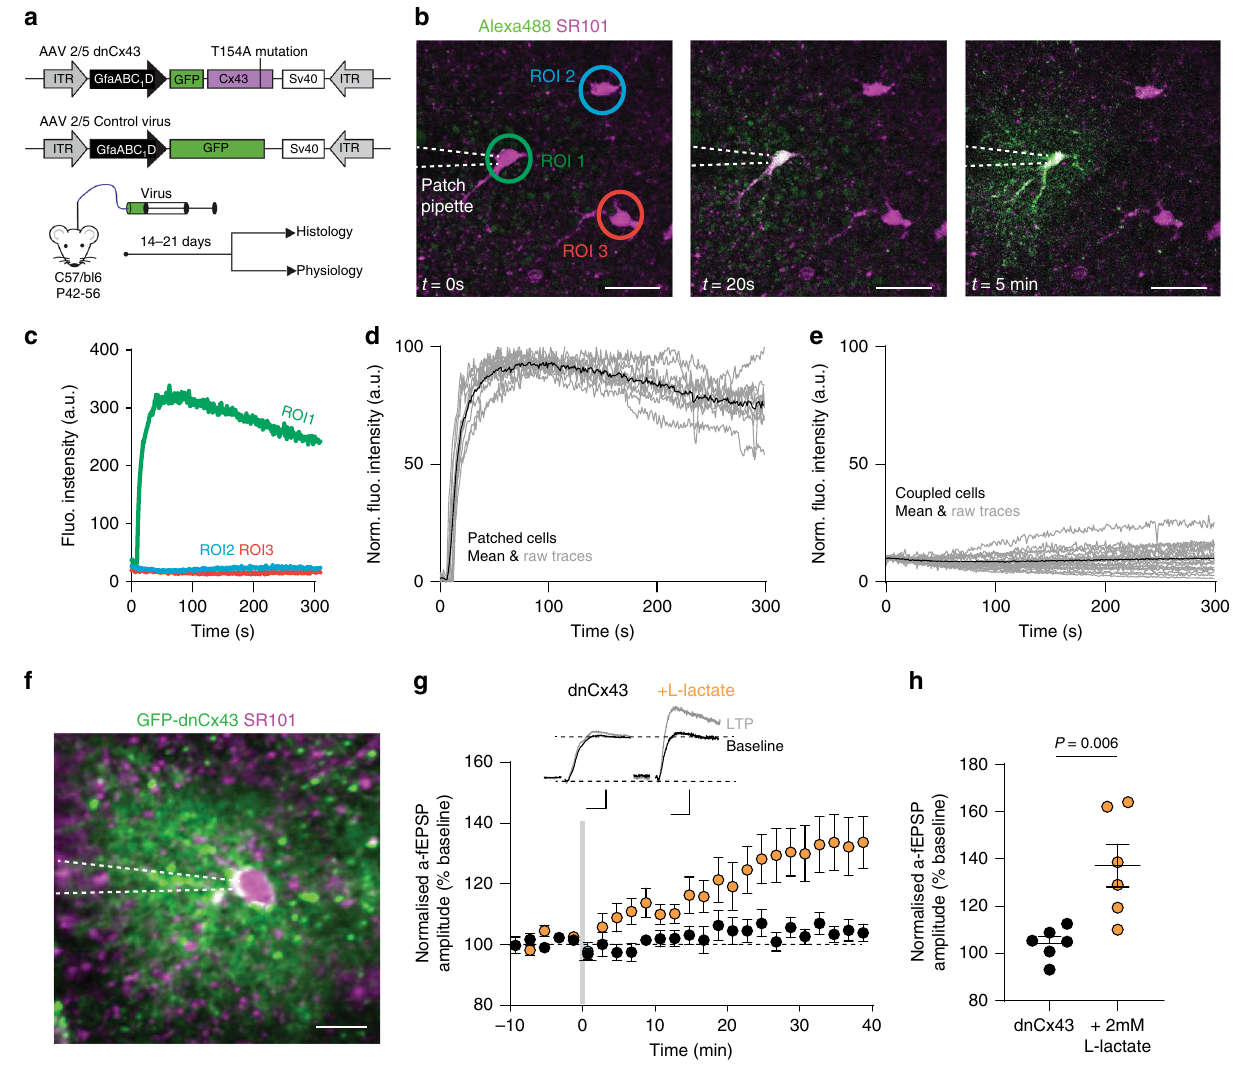
Fig. 5 Reduction of connexin 43 gap junction channel function impairs LTP and can be rescued by overcoming a syncytial energetics de fi cit. a Diagram indicating dnCx43 construct with GFP-tag and single point mutation and control GFP virus, both under GfaABC 1 D promoter. Adult mice were injected before histology and physiological recordings. b Representative images of the effect of dnCx43 expression on astrocyte coupling at t = 0 s (before patching), t = 20 s following whole-cell patch-clamp where dye is in patched astrocyte, and at t = 5 min where dye remains in patched cell and has not spread to nearby astrocytes. Scale bar 35 µ m. c Raw data showing alexa-488 fl uorescence intensity changes in astrocytes from b . d Normalized fl uorescence intensity of patched cells expressing dnCx43. Black trace is mean, gray traces are raw data from 10 patched astrocytes. e Normalized fl uorescence intensity of coupled cells expressing dnCx43. Black trace is mean, gray traces are raw data from 21 coupled astrocytes. f Two-photon average intensity z-projection of single dnCx43-expressing astrocyte co-labeled with SR101. Scale bar 15 µ m. g Normalized a-fEPSP amplitude demonstrating effects of dnCx43 (black) on LTP induced by 10 s theta burst stim (gray bar), which was rescued by supplementing astrocytes with 2 mM L -lactate (orange). dnCx43: n = 5 mice, n = 6 cells. dnCx43 + L -lactate: n = 5 mice, n = 6 cells. Error bars: mean ± s.e.m. Unpaired t -test. Inset, example traces pre- (black) and post- (gray) LTP induction. Scale bars 0.5 mV, 10 ms. h Scatter dot plot depicting the extent of long-term plasticity 30 – 40 min following theta burst stimulation (data from g ). Error bars: mean ± s.e.m. Unpaired t